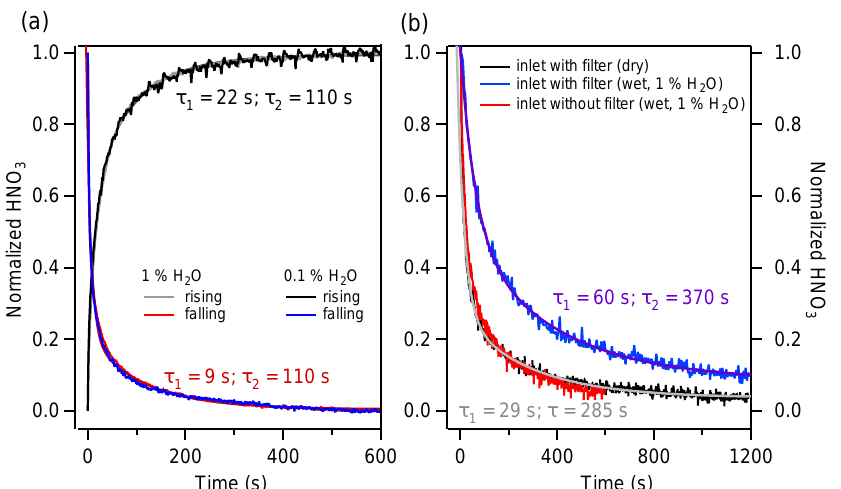
Figure 5. ( a ) Normalized response of the instrument’s reduced inlet to a step-wise HNO tion change after a 3-way position switch in dry and humid conditions for both rising and falling edges. ( b ) Normalized response of the extended inlet of the instrument to a step change of the HNO concentration. Three configurations are shown: the response with a filter in dry (black) and humid (blue) conditions, and the response without a filter in humid conditions